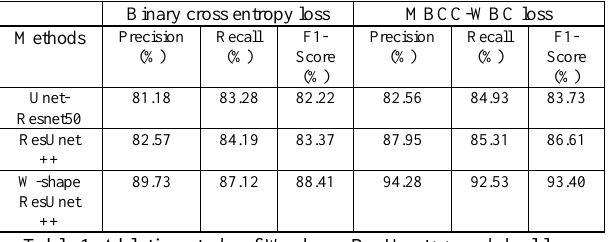
Table 1. Ablation study of W-shape ResUnet++ and dual loss based on MBCC-WBCE loss on LEVIR-CD validation set.